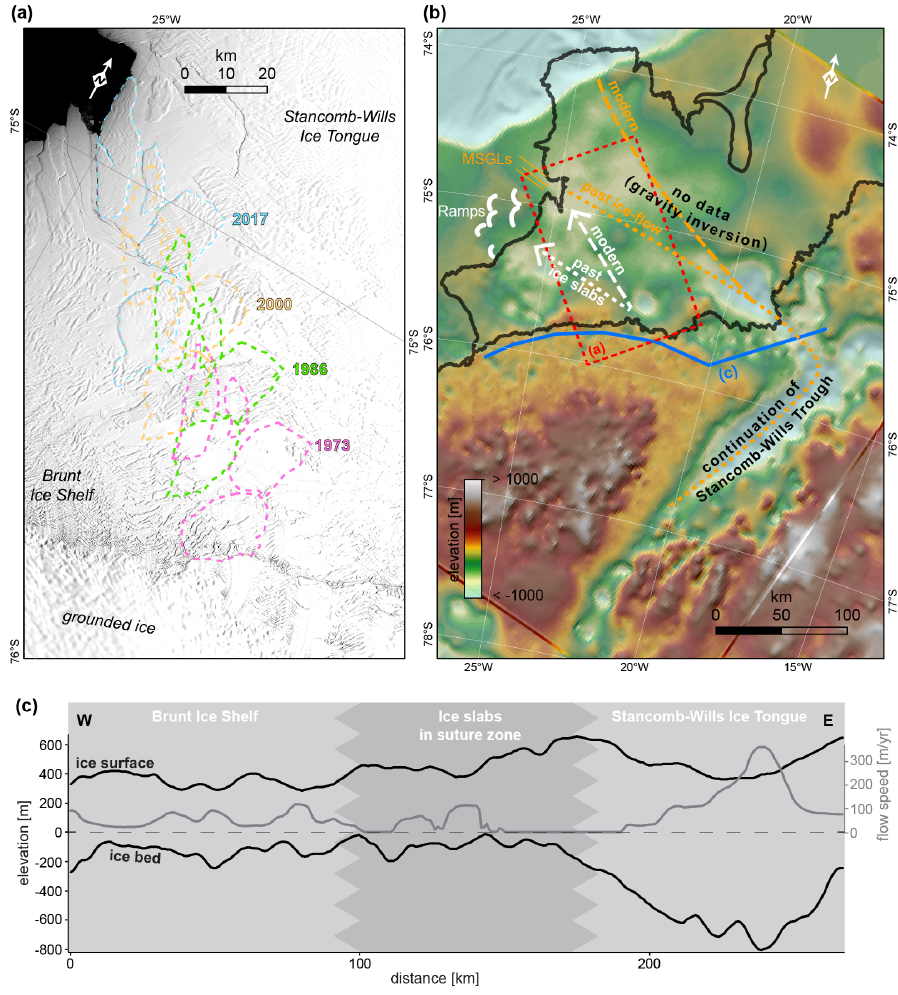
Figure 9. (a) Landsat satellite image (courtesy of the US Geological Survey) showing the location of four large ice slabs enclosed within perennial sea ice in February 2017 and their trajectory since 1973. (b) Map of sub-ice-shelf bathymetry, inferred from gravity inversion in the central part (Hodgson et al., 2019), with locations of mega-scale glacial lineations (Class C and D) and iceberg ramps (Class H). Furthermore, the main trajectory of large ice slabs under modern conditions (see a ) and the assumed main trajectory of paleo-ice-slabs at the time of ramp formation are shown. The inferred direction of paleo-ice-streaming supports the continuation of Stancomb-Wills Trough into a modern subglacial trough. (c) Profiles of ice surface, bedrock topography (Fretwell et al., 2013), and ice flow speed (Mouginot et al., 2017) inshore of the grounding line (for the location, see b ). Note the high flow velocity in the deepest section flowing into Stancomb-Wills Ice Tongue and the shallow bedrock altitude with thick ice in the suture zone forming the large ice